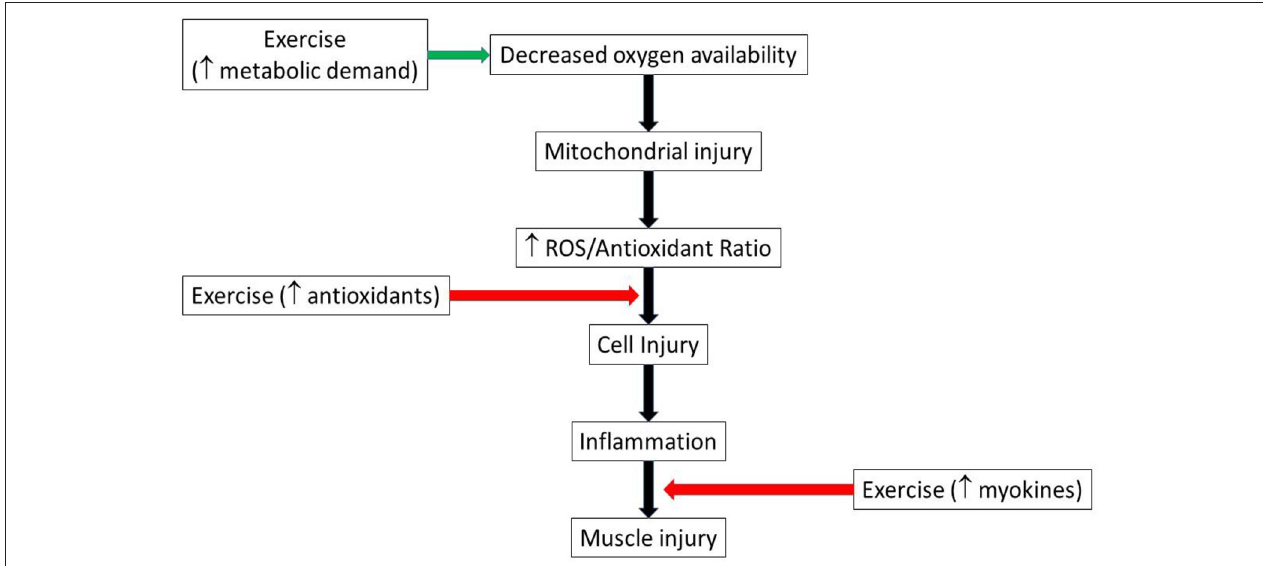
FIGURE 2 | Schematic illustrating possible pathways by which exercise could both aggravate and mitigate muscle injury. Green arrow indicates injury promotion, while red indicates injury limitation pathways. ROS, reactive oxygen